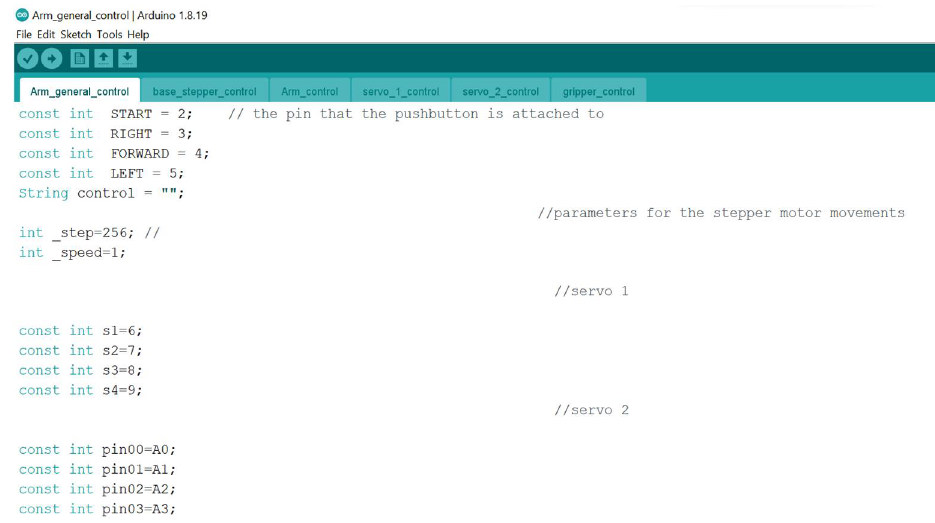
Figure 6. Decomposition principle in action: the organization of the final code in Arduino IDE.